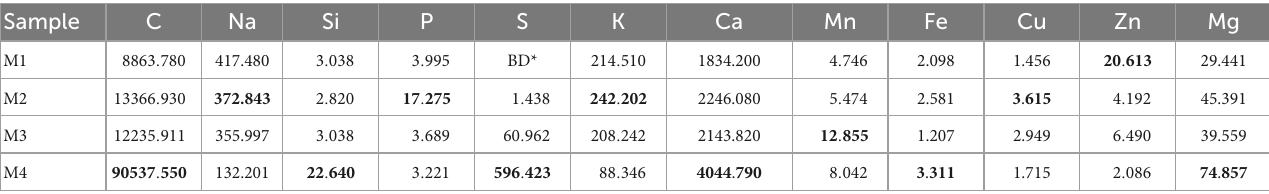
TABLE 2 Chemical analysis of ions in meltwater. Sample